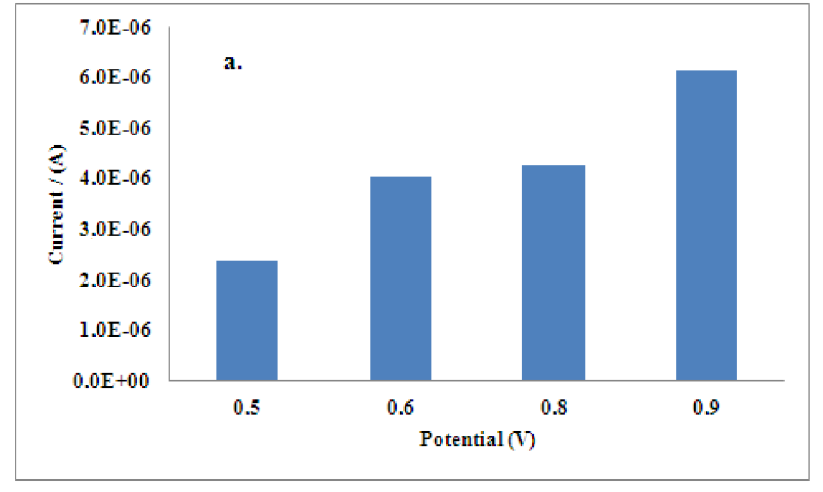
Figure 1. ( a ) Current response of ATI with potential, ( b ) Current response of ATI with pH, ( c ) Current response of ATI